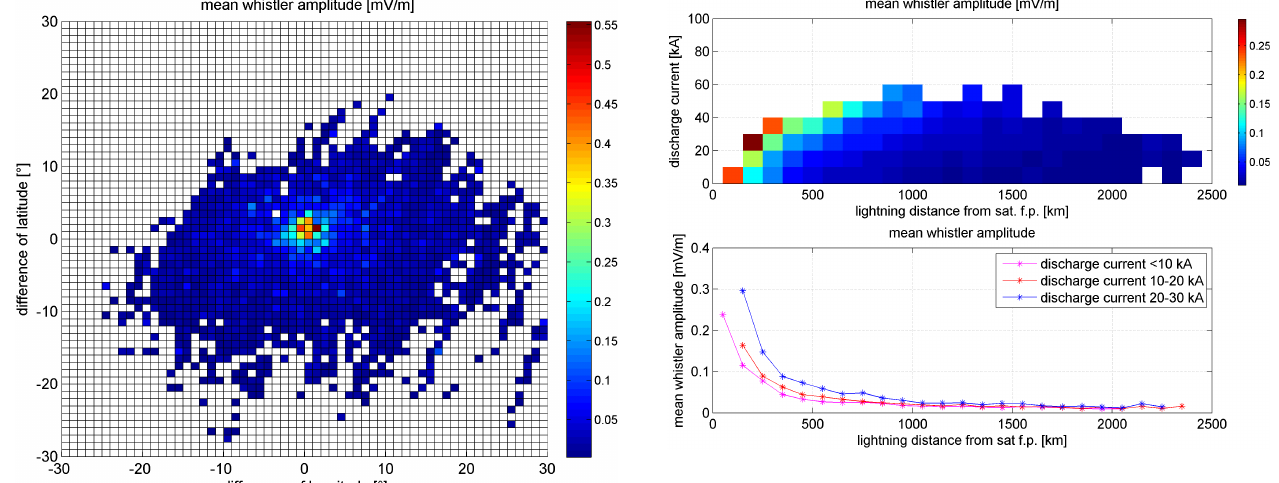
Fig. 6. Mean whistler amplitudes as a function of longitudinal and latitudinal difference between the magnetic footprint and locations of lightning for daytime cases.